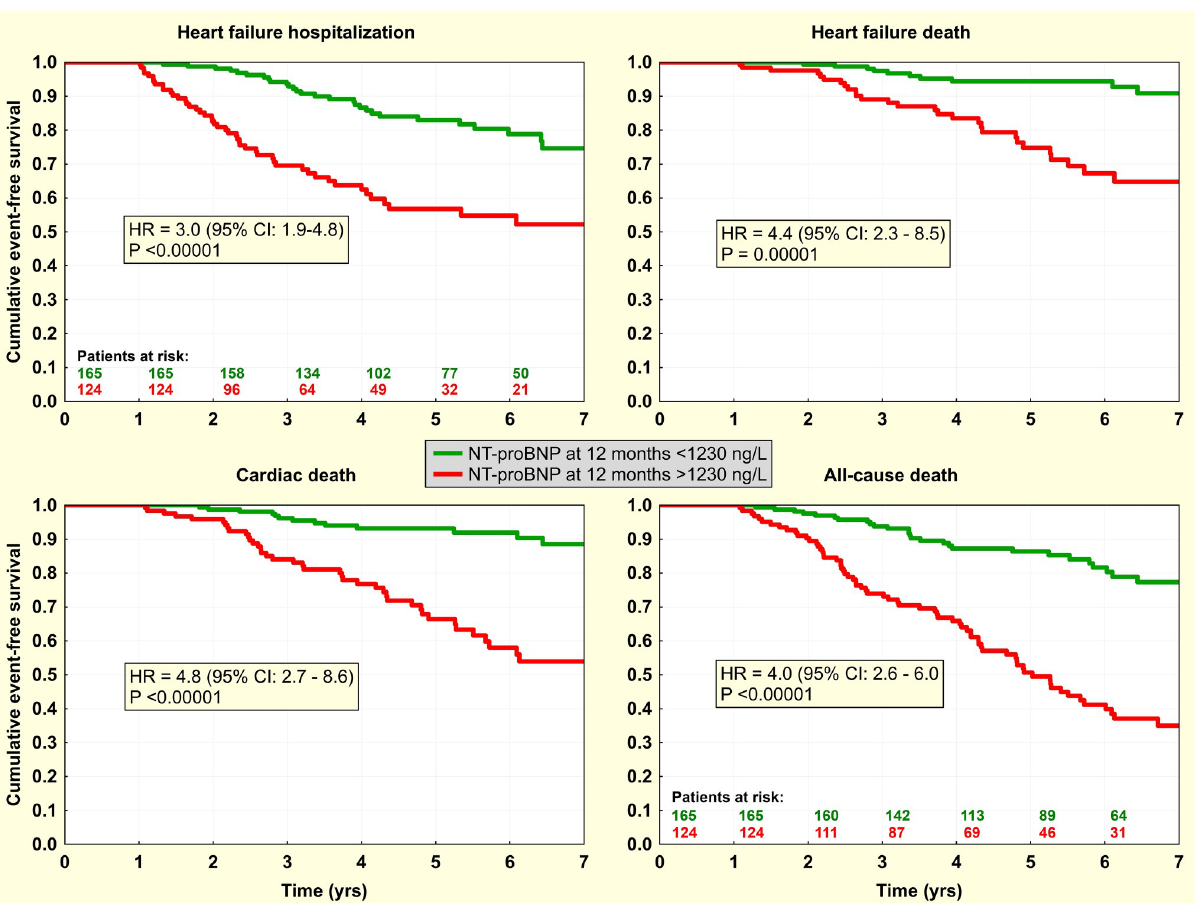
Fig 3. Event-free survival according to post-CRT level of NT-proBNP. Kaplan-Meier curves for the first heart failure hospitalization / death and cardiac / all-cause death according to 12-month NT-proBNP level with dichotomy of 1230 ng/L.